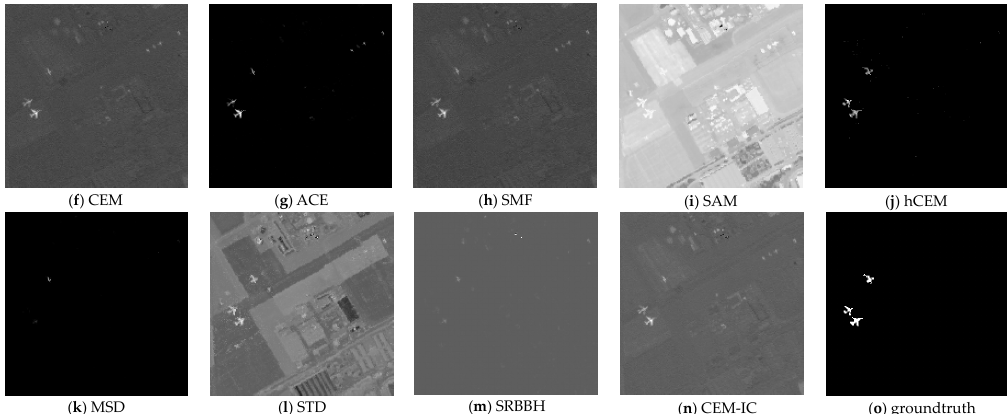
Figure 9. Detection results of the San Diego airport data. ( a – e ) results of the proposed ADHBS method in different layers, corresponding to different degree of background separation. ( f – n ) constrained energy minimization (CEM), adaptive coherence estimator (ACE), spectral matched filter (SMF), SAM, hierarchical CEM (hCEM), matched subspace detector (MSD), sparsity-based target detector (STD), sparse representation-based binary hypothesis (SRBBH), and inequality constraint on CEM (CEM-IC), respectively. ( o ) the ground truth of the target.